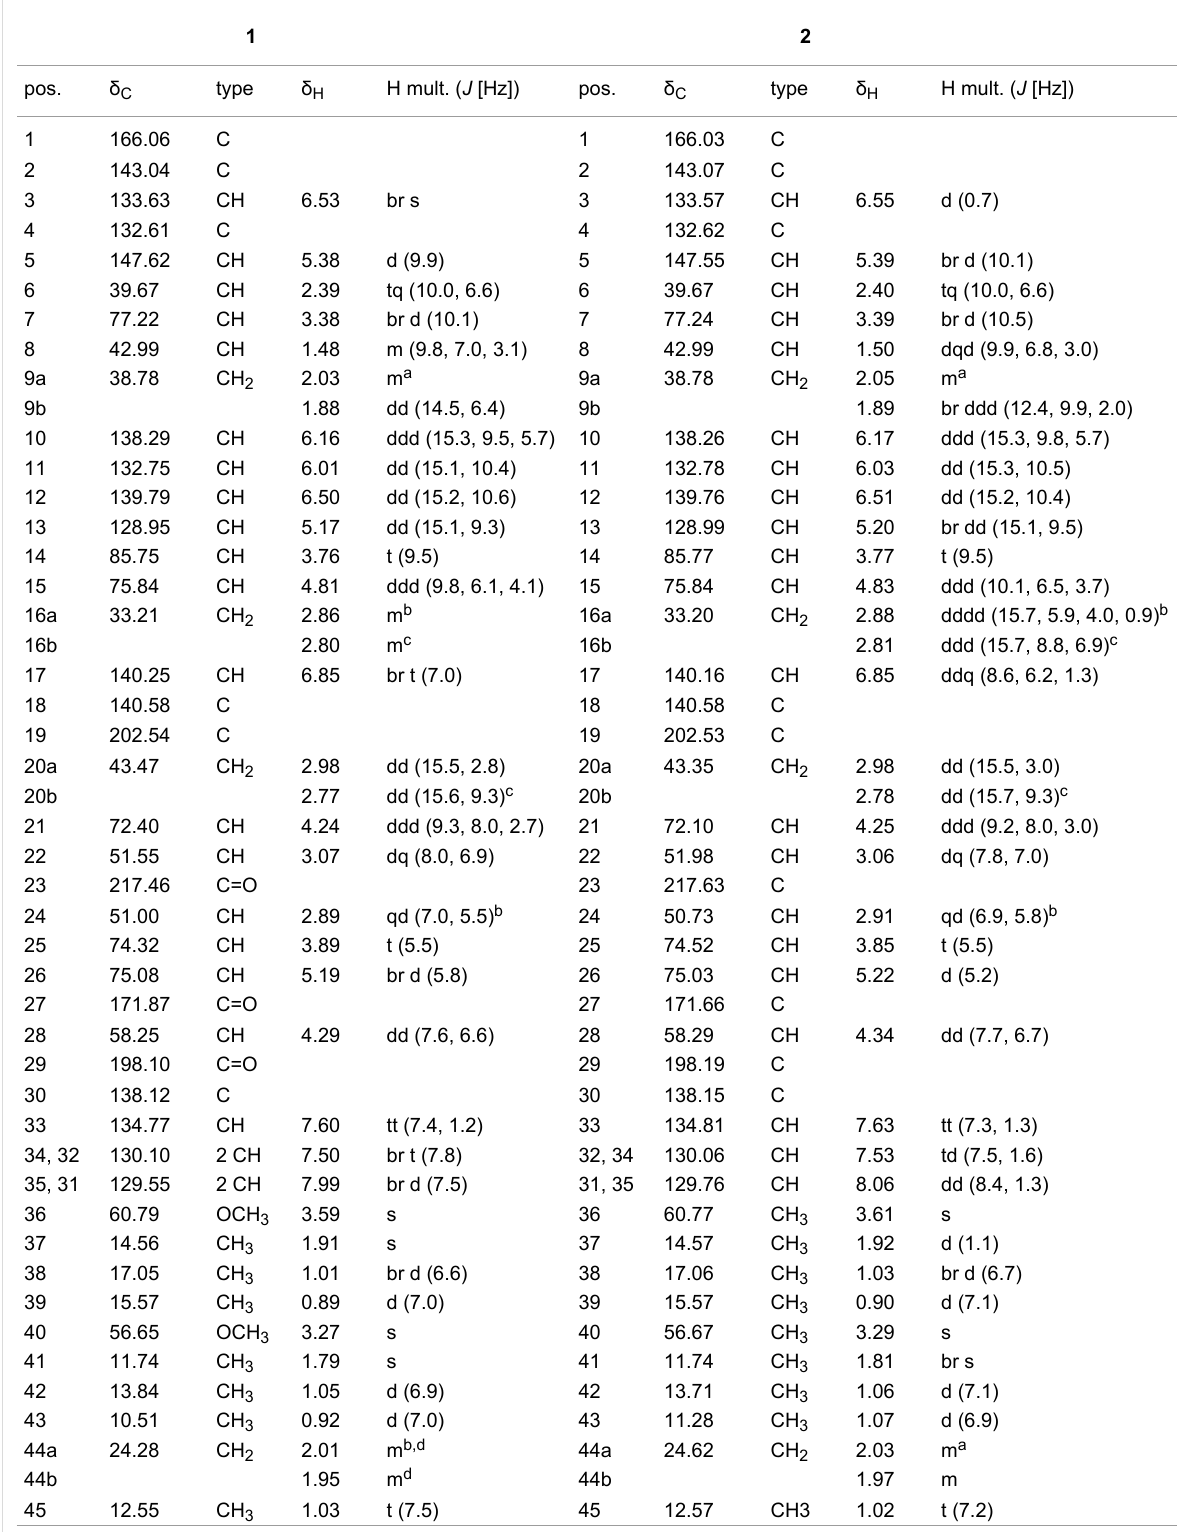
Table 1: NMR data of lanyamycin epimers ( 1 and 2 ) in CD 3 OD at (150/125